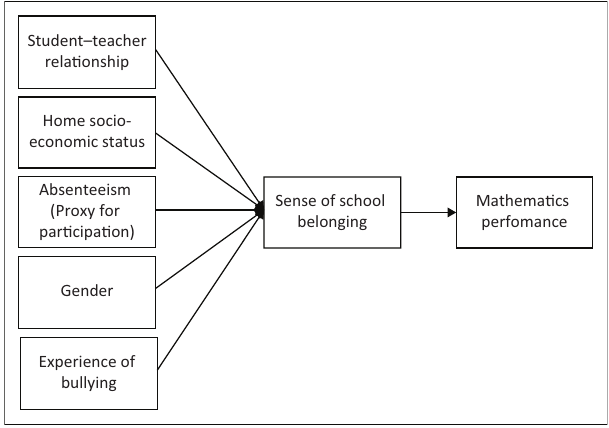
FIGURE 1: Conceptual and data analysis framework of the